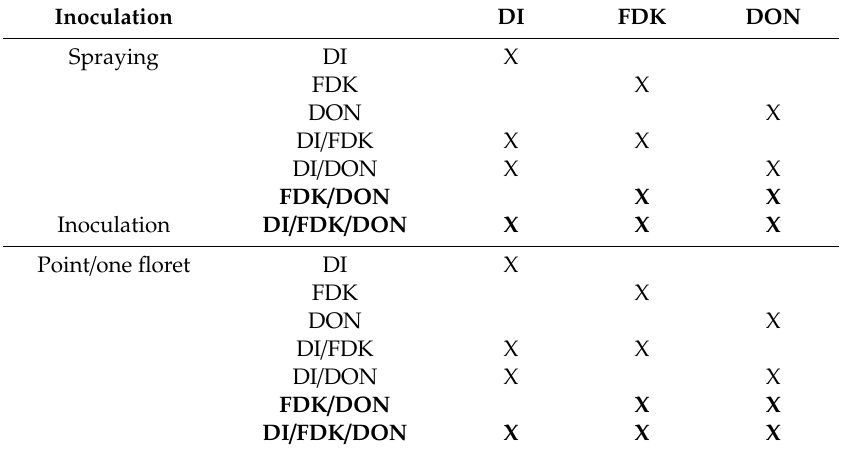
Table 6. Possible QTL functions with activity to di ff erent FHB traits in wheat [86]. Inoculation DI FDK DON Spraying DI X FDK X DON X DI / FDK X X DI / DON X X FDK / DON X X Inoculation DI / FDK / DON X X X Point / one floret DI X FDK X DON X DI / FDK X X DI / DON X X FDK / DON X X DI / FDK / DON X X